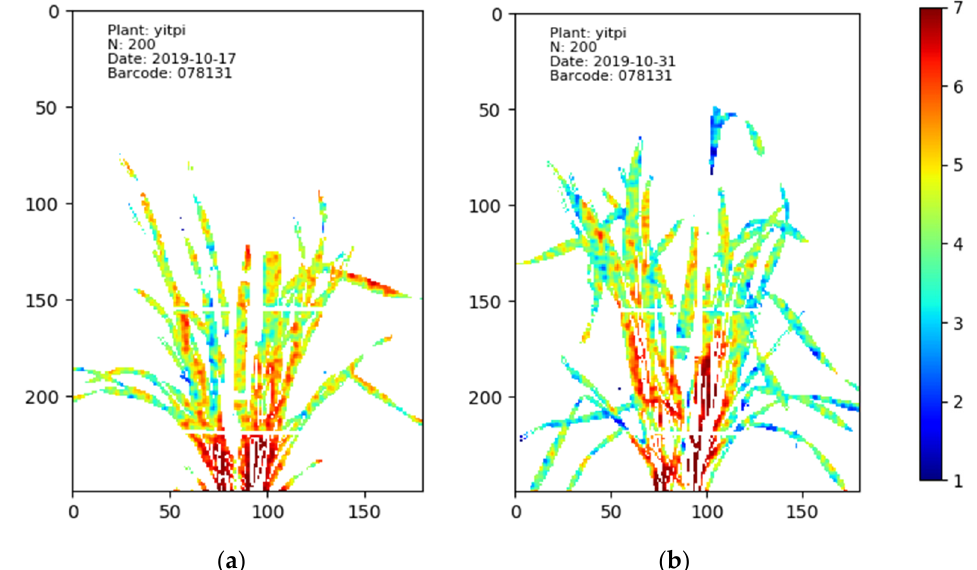
Figure A6. The N distribution maps of Yitpi on different days with the same N treatments. Image ( a )